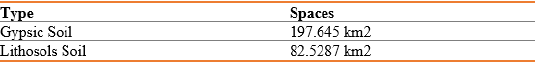
Table 6 : Spaces of soil types